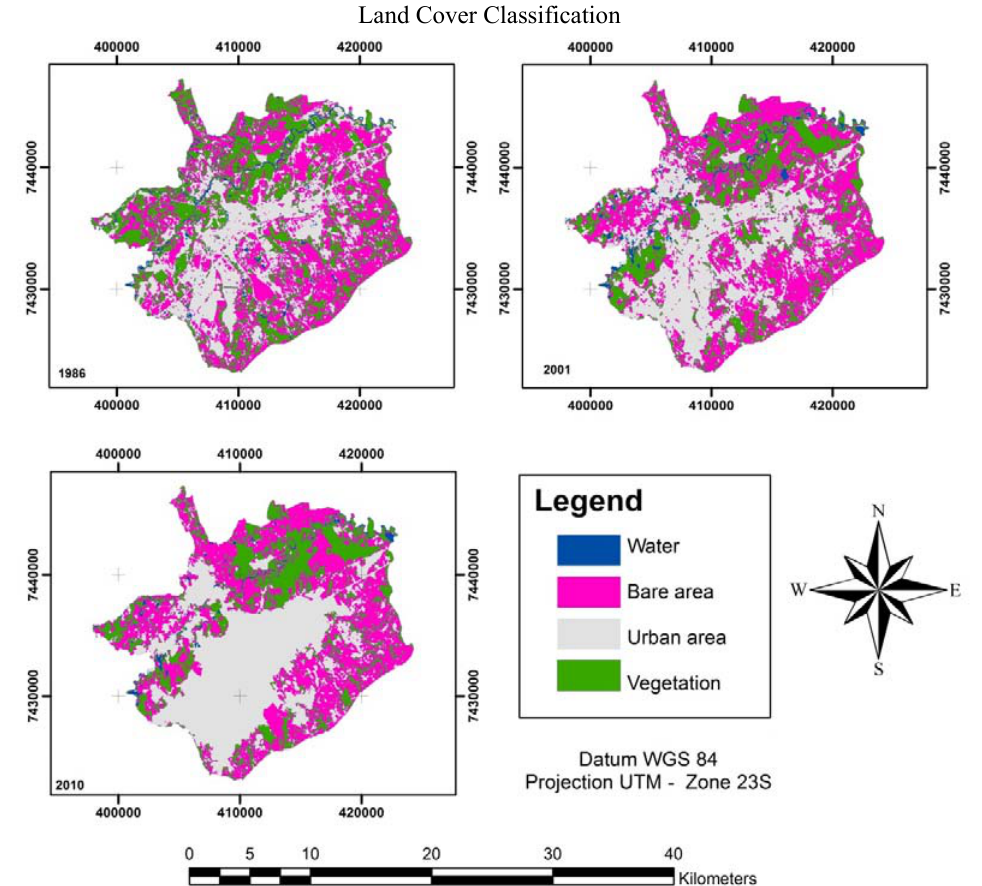
Figure 2. Hybrid-supervised classification of the TM/Landsat 5 image from 1986, 2001 and